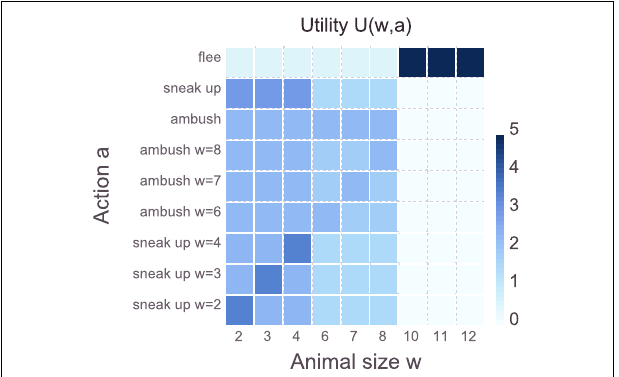
FIGURE 5 | Predator-prey utility function U ( w , a ) . The actor encounters different groups of animals – small, medium-sized, and large – and should hunt small and medium-sized animals for food and flee from large animals. Animals within a group have a similar size w : small animals 2 {2,3,4} size-units, medium-sized animals 2 {6,7,8} size-units, and large animals 2 {10,11,12} size-units. For hunting – denoted by the action a – the actor can either ambush the other animal or alternatively sneak up to the other animal and strike once close enough. In general, sneaking up works well on small animals as they cannot hear very well, whereas medium-sized animals can hear quite well which decreases the chance of a successful sneak-up. The ambush works equally well on both groups of prey. Large animals should never be engaged, but the actor should flee in order to avoid falling prey to them. In addition to the generic hunting patterns that work equally well for all members of a group, for small animals there are specific sneak-up patterns that have an increased chance of success if applied to the correct animal but a decreased chance of success when applied to the wrong animal. For medium-sized animals, there are specific ambush behaviors that have the same chance of success as the generic ambush behavior when applied to the correct animal but a decreased chance of success when applied to the wrong animal. Since the specific ambush behaviors for the medium-sized animals have no advantage over the generic ambush behavior but require more information processing, any bounded rational actor should never choose the specific ambush behaviors. This somewhat artificial construction is meant to illustrate that bounded rational actors do not add unnecessary complexity to their behavior. See main text for more details on the